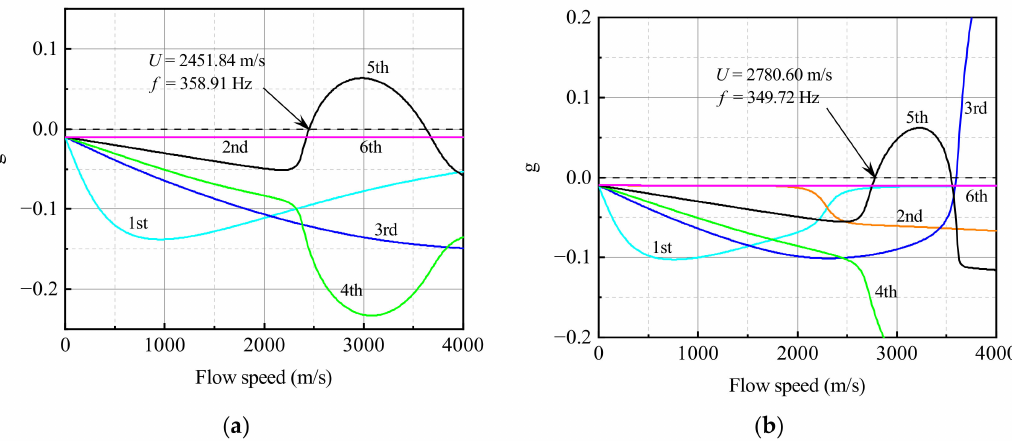
Figure 11. Flutter characteristics at different sweep angles. ( a ) Sweep angle is 20 deg. ( b ) Sweep angle is 50